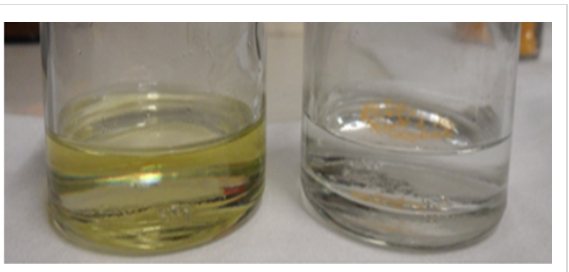
Figure 2: Ferrocene diluted in toluene (left) and ferrocene diluted in water (right) after sonication operation.